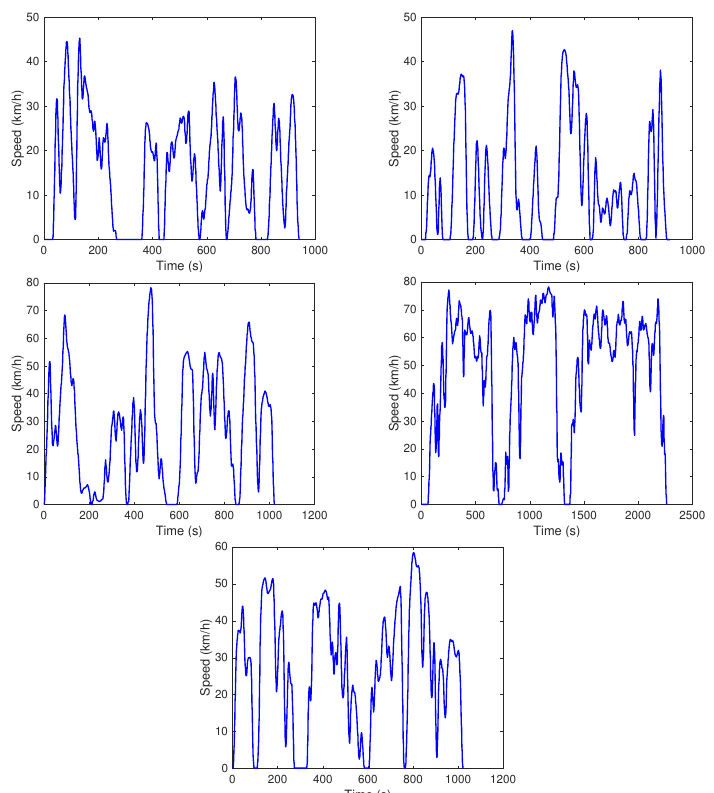
Figure 10. Five typical driving cycles after cluster